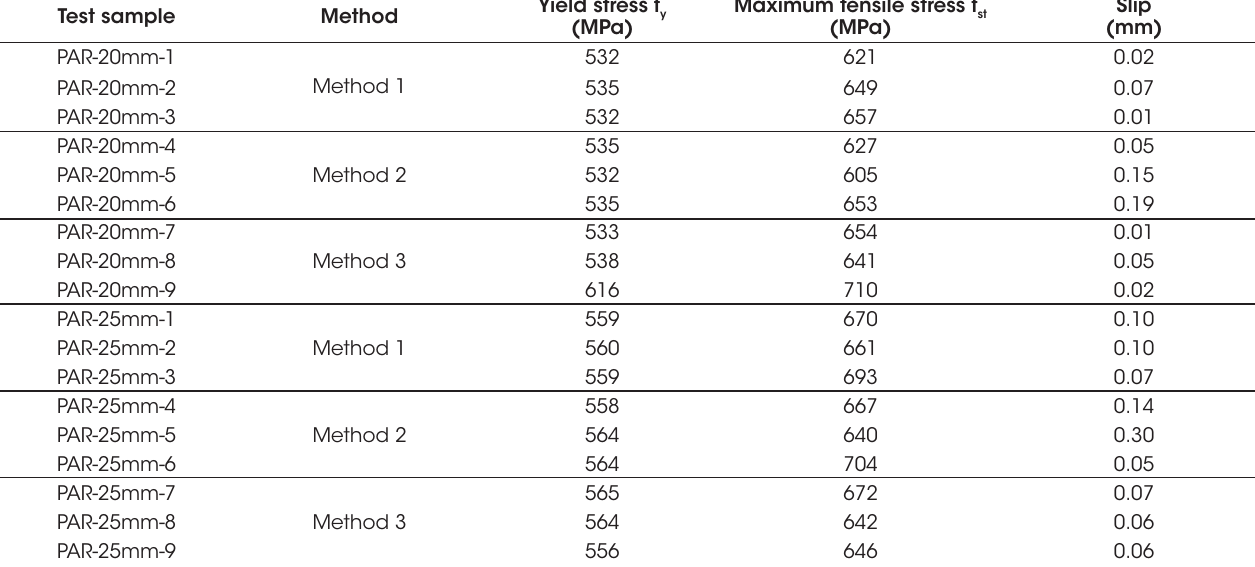
Results of performance tests on steel bars with shear bolted mechanical